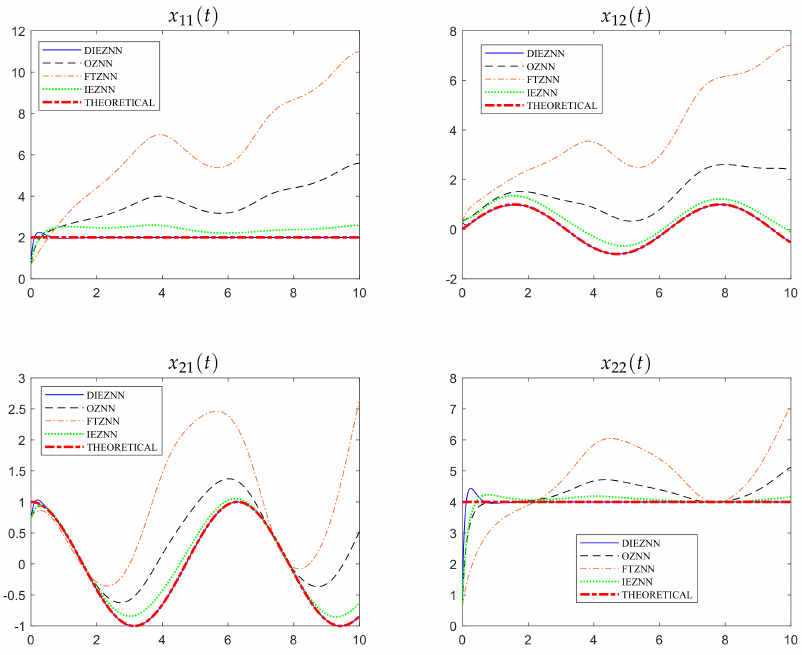
Figure 1. State trajectories of the DIEZNN model (Equation (14)), OZNN model (Equation (5)), FTZNN model (Equation (8)) and IEZNN model (Equation (11)) for solving Equation (1) under linear noise N ( t ) = 10 + 10 t when the design parameters γ = 5. The neural − state solutions to the DIEZNN model (Equation (14)), the OZNN model (Equation (5)), FTZNN model (Equation (8)) and IEZNN model (Equation (11)) are represented by blue solid curves, black dashed curves, orange dash − dotted curves and green dotted curves, respectively. The theoretical solution is represented by red dash − dotted curves.